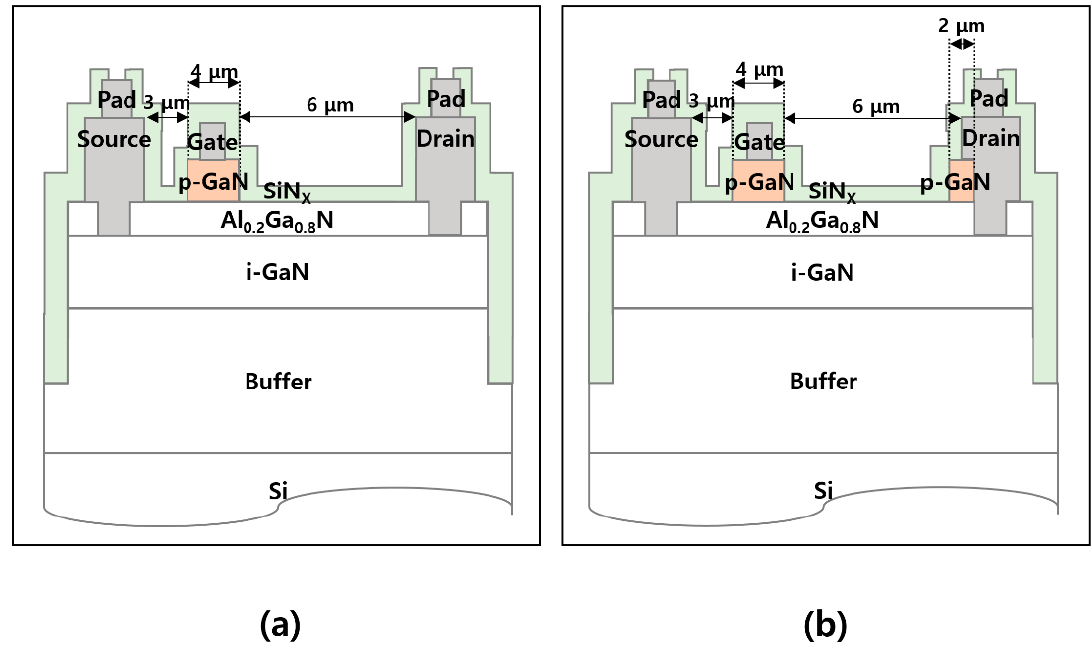
Figure 6. Cross-sectional schematics of ( a ) fabricated p-GaN gate AlGaN/GaN HFET and ( b ) unidirectional HFET.